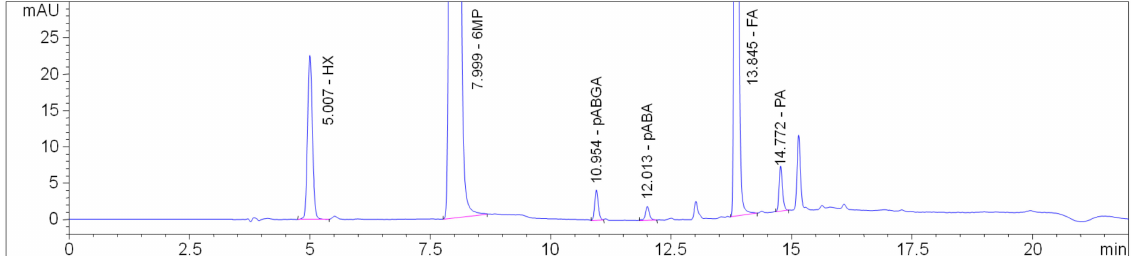
Figure 5. Chromatogram of a standard solution containing 10 µ g/mL of hypoxanthine (HX), 500 µ g/mL of 6MP, 0.5 µ g/mL of p-aminobenzoylglutamic acid (pABGA), 0.125 µ g/mL of p-aminobenzoic acid (pABA), 25 µ g/mL of FA and 0.5 µ g/mL of pteroic acid